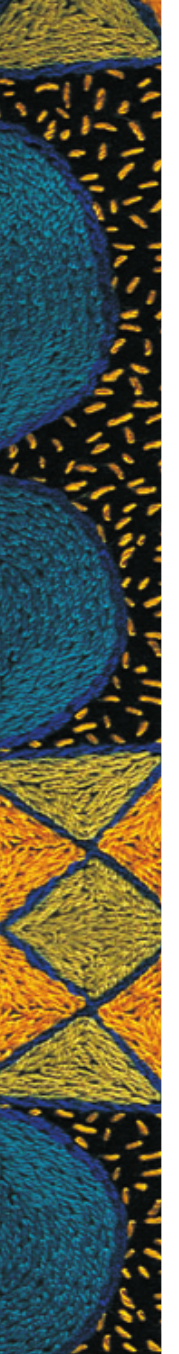
TABLE I. OVERVIEW OF HIV SERVICES IN